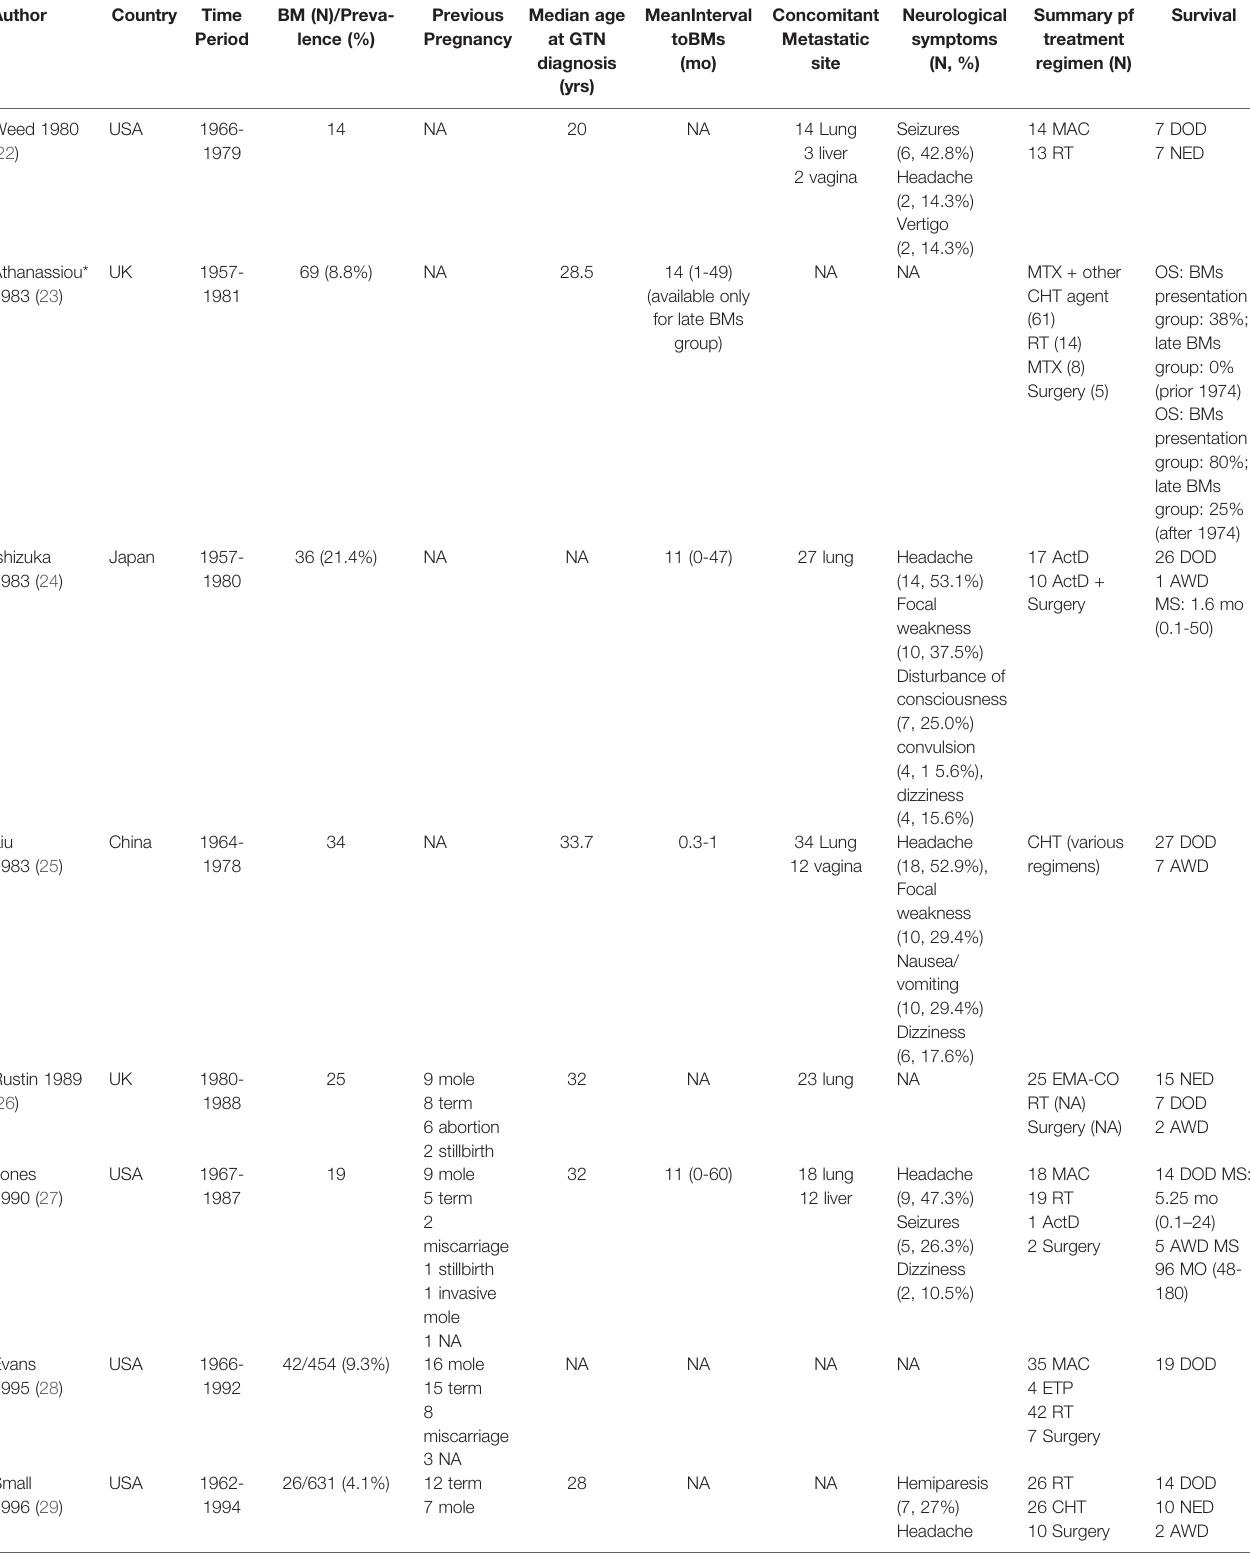
TABLE 1 | Overview of clinical-pathological features, treatments, and outcomes of patients with BMs from